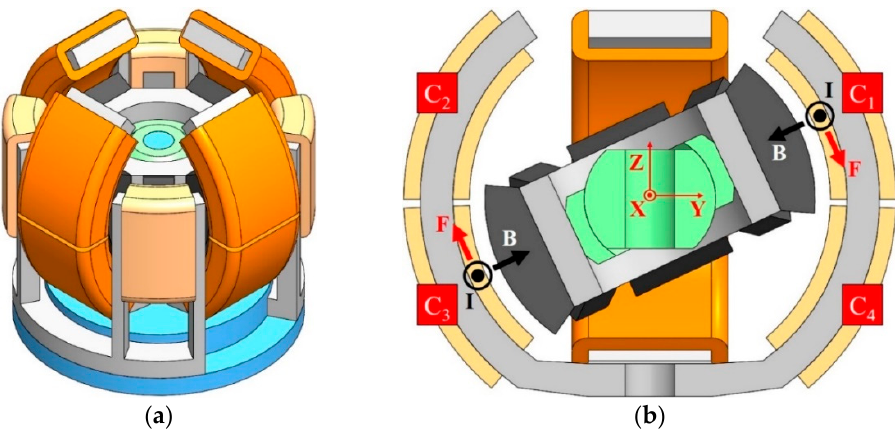
Figure 5. ( a ) Basic structure of proposed 3-DOF spherical motor; ( b ) Y-Z cross-section of proposed 3-DOF spherical motor when the rotor is rotating around the X -axis at 25°.